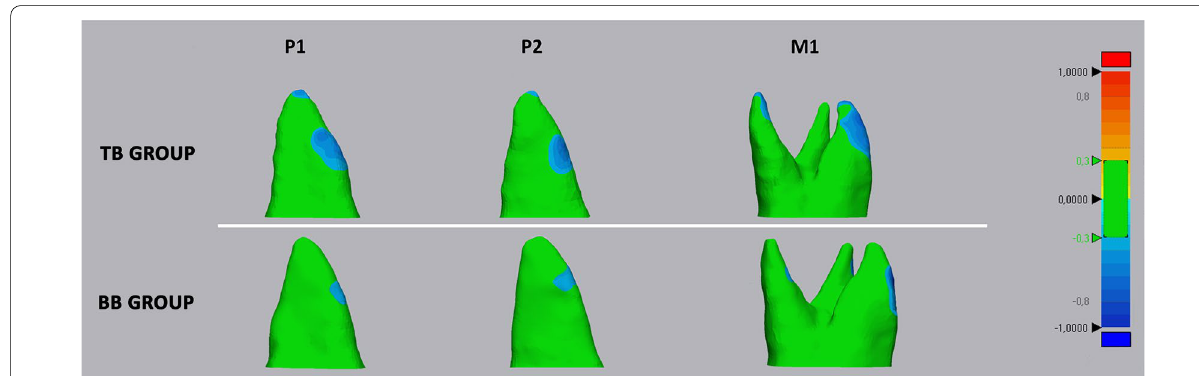
Fig. 5 Deviation analysis between the T0 and T1 radicular models of first molar (M1), first premolar (P1), and second premolar (P2) in both tooth‑borne (TB) and bone‑borne (BB) expander groups. The colored map shows the deviations (negative blue, positive red) between the mesh models. The range of tolerance (green color) was set at 0.3 mm. The color‑coded map showed that the reduction in cementum (blue‑tone) ± was localized in the apical, bucco‑apical, and bucco‑medial radicular areas of both abutment and un‑anchored teeth in the TB group. A similar resorption pattern was identified in the BB group, despite the absence of detectable deviation at the